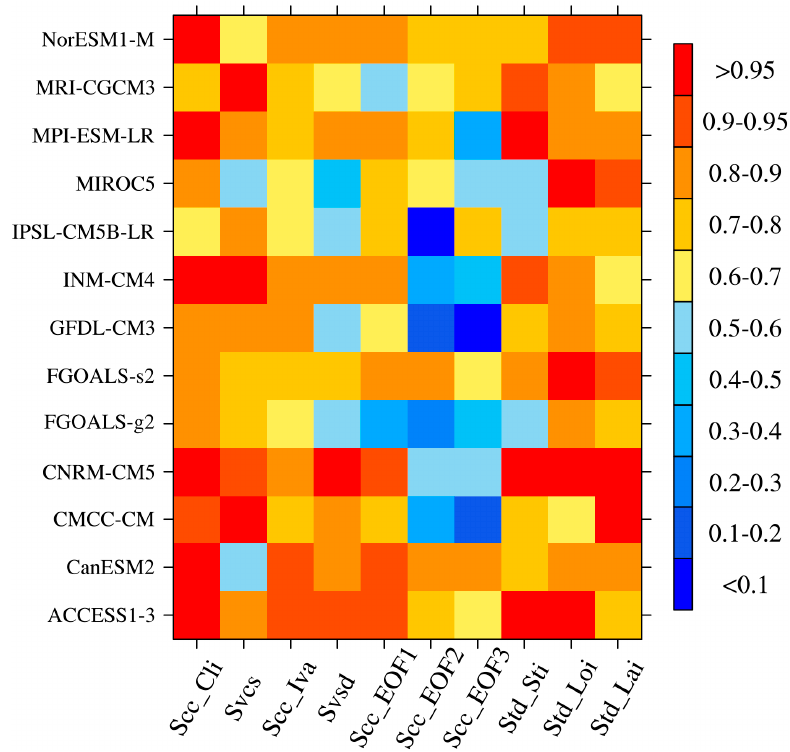
Figure 10. Diagram indicating the relative ability of (top to bottom) the CMIP5 models in simulating the climatology and interannual variability of WNPST (Scc_Cli, Scc_Iva, Scc_EOF1, Scc_EOF2 and Scc_EOF3 on horizontal axis represents spatial correlation coefficients (Scc) of climatology (Cli), interannual variation of amplitude (Iva), the first mode (EOF1), the second mode (EOF2) and the third mode (EOF3) respectively; Svcs, Svsd, Std_Sti, Std_Loi and Std_Lai represents capability of model in simulating the spatial variation of climatology strength (Svcs), standard deviation (Svsd), and the interannual variability (Std) of the WNPST strength index (Sti), longitude index (Loi) and latitude index (Lai) respectively (represented by 1-deviation)).